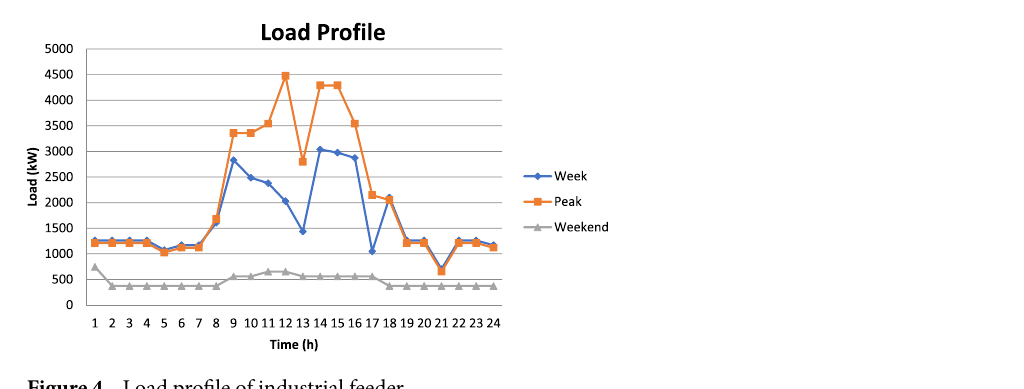
Figure 3. 11 kV Industrial feeder 90 bus system.